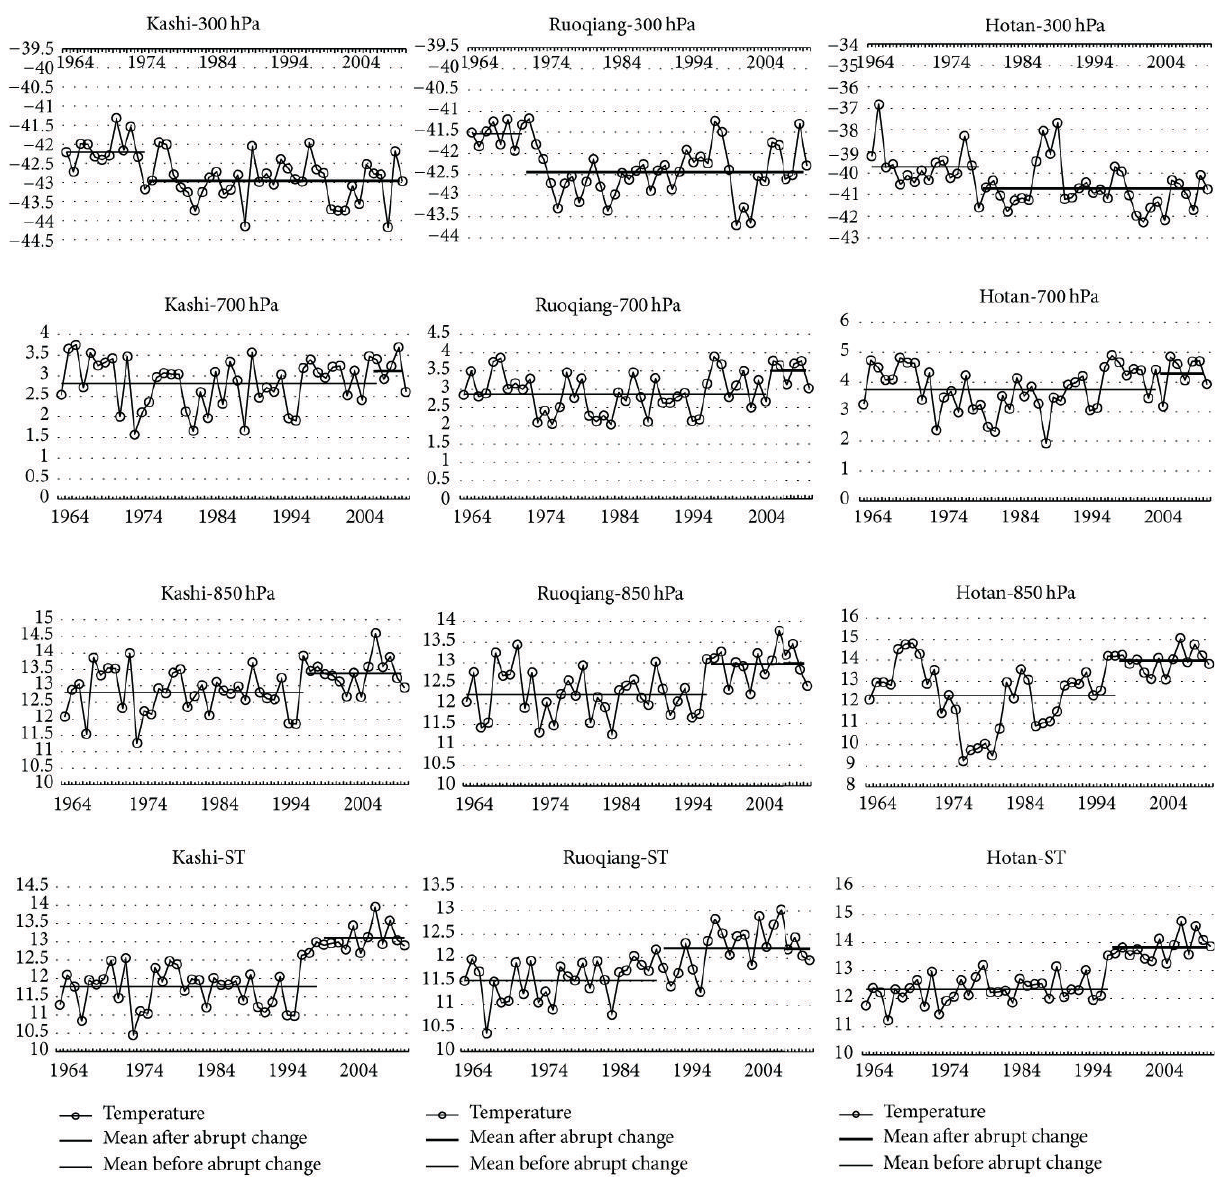
Figure 4: The difference in mean temperature of abrupt change before and after.